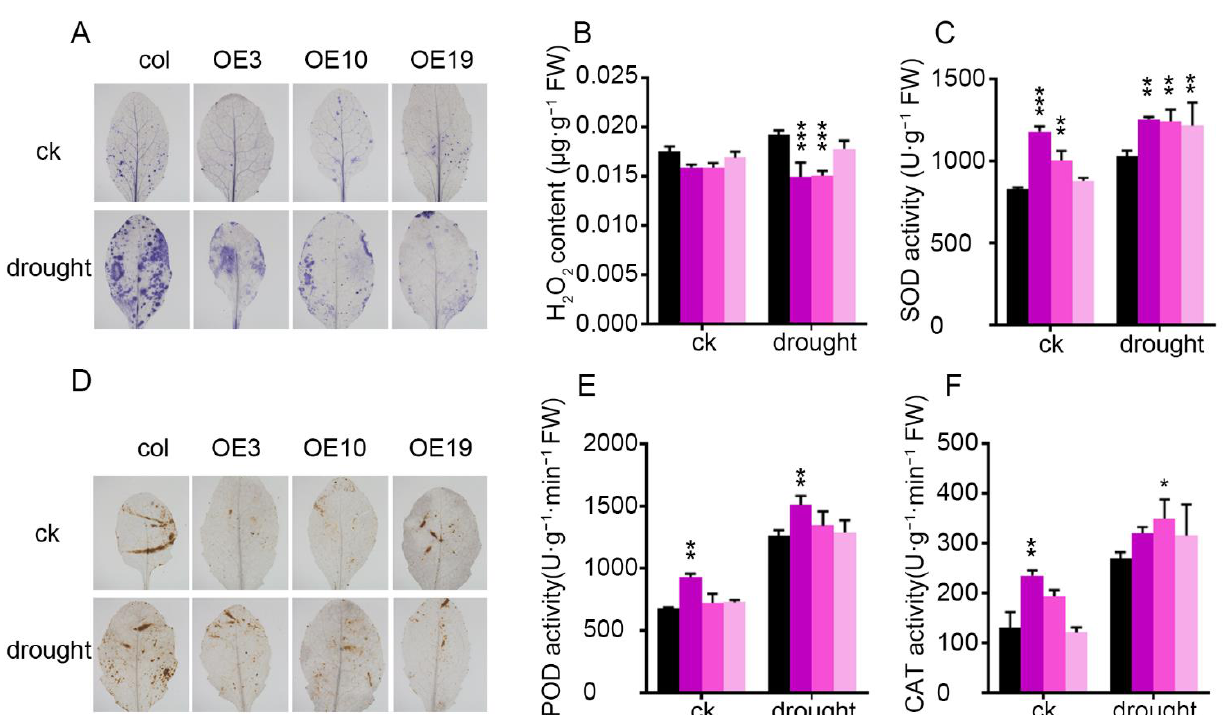
Figure 7. Reactive oxygen species staining and physiological indices in ZmLBD5 transgenic Ara- bidopsis: ( A , D ) NBT and DAB staining of leaves for H 2 O 2 from ZmLBD5 transgenic seedlings and wild-type plants under normal conditions and drought stress (3-week-old seedlings were subjected to drought for 7 days). ( B ) H 2 O 2 content in leaves from ZmLBD5 transgenic seedlings and wild-type plants under normal conditions and drought stress (withholding water for 7 days). ( C ) SOD activity, ( E ) POD activity, and ( F ) CAT activity in leaves from ZmLBD5 transgenic seedlings and wild-type plants under normal and drought conditions (withholding water for 7 days). Significance was ana- lyzed by one-way ANOVA. * p < 0.05; ** p < 0.01; *** p < 0.001. All bars represent means ± SD ( n = 6).